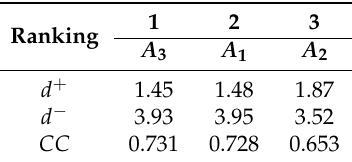
Table 12. Ranking and results by fuzzy TOPSIS.